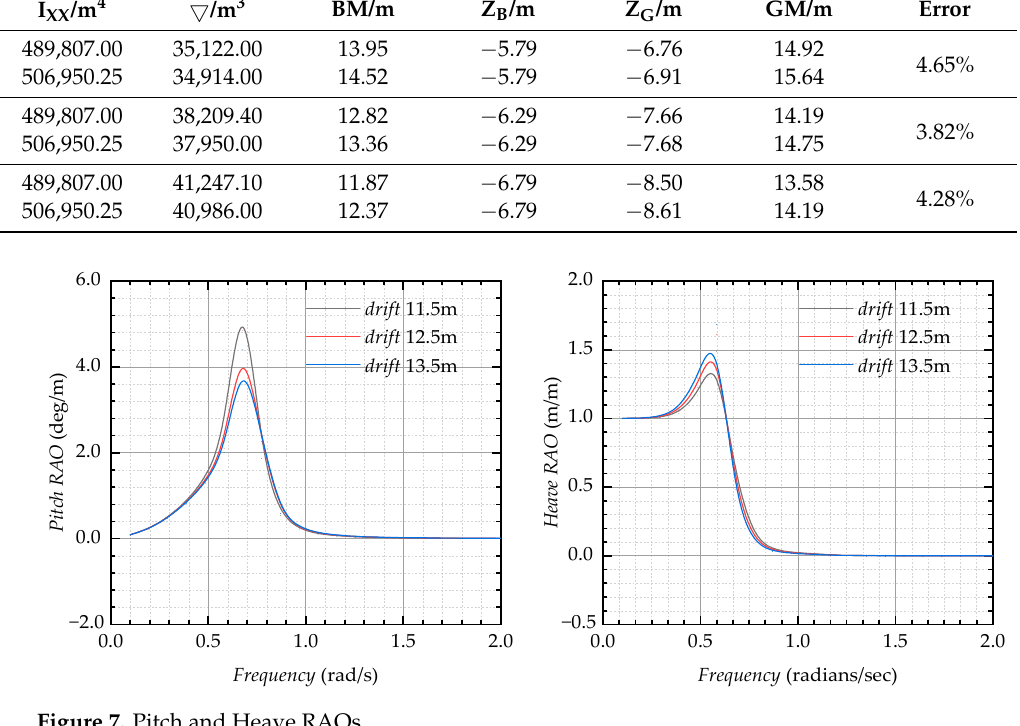
Figure 7. Pitch and Heave